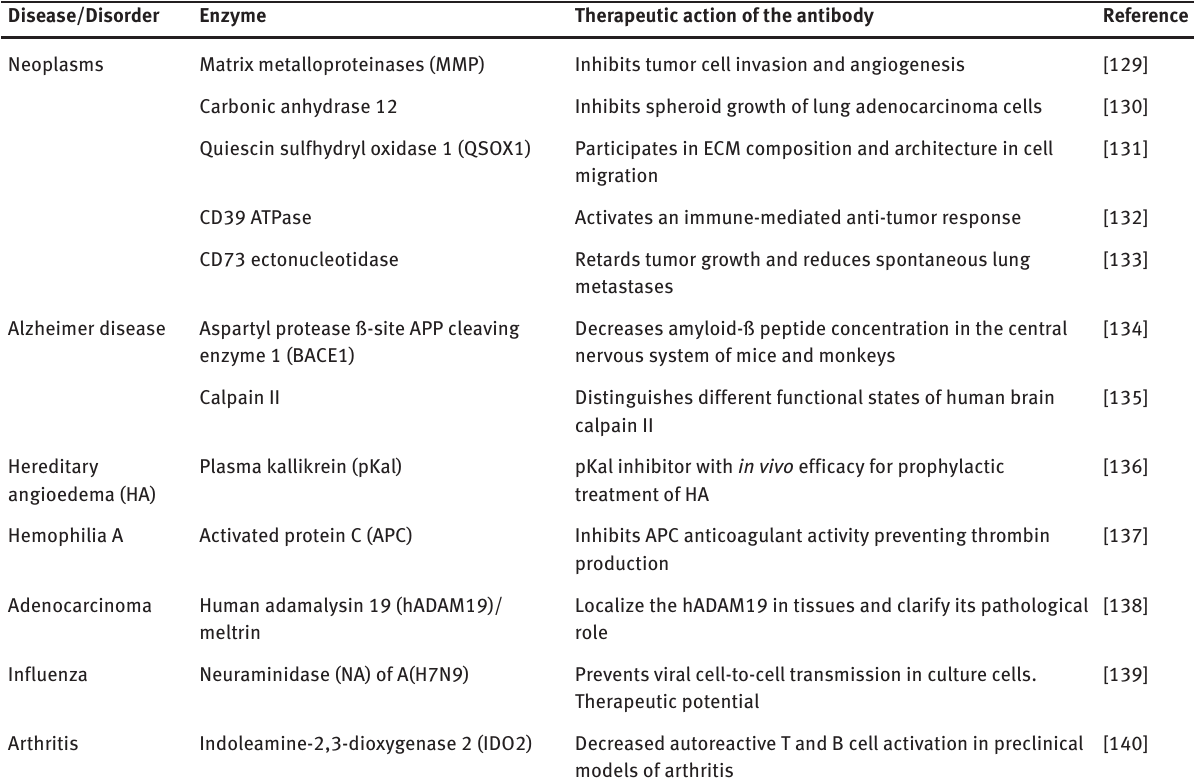
Table 5 : Diseases that could be treated by anti-enzyme inhibiting antibodies following the classification developed at the Institute of Biochemistry and Bioinformatics of the Technical University of Braunschweig